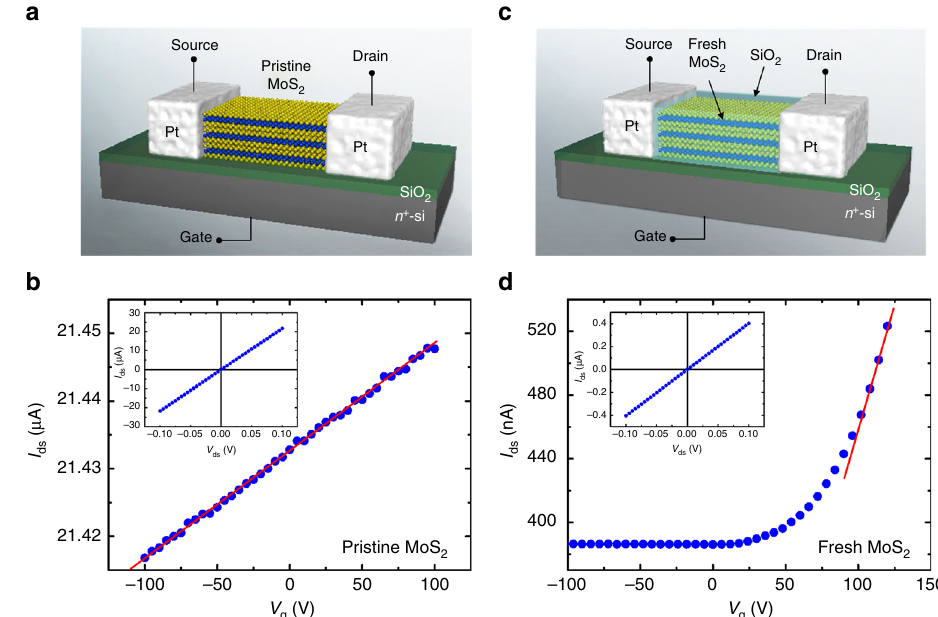
Fig. 9 FET measurements of the pristine and fresh MoS 2 nano fl akes. The schematic FET device with a bottom-gate con fi guration and I ds – V g curves for the a – b pristine and c – d fresh MoS 2 nano fl akes. The V ds is 0.1 V. The dimensions of the nano fl akes are l = 4.3 μ m, w = 2.3 μ m, and t = 52 nm for the pristine sample and l = 5.3 μ m, w = 2.1 μ m, and t = 250 nm for the fresh